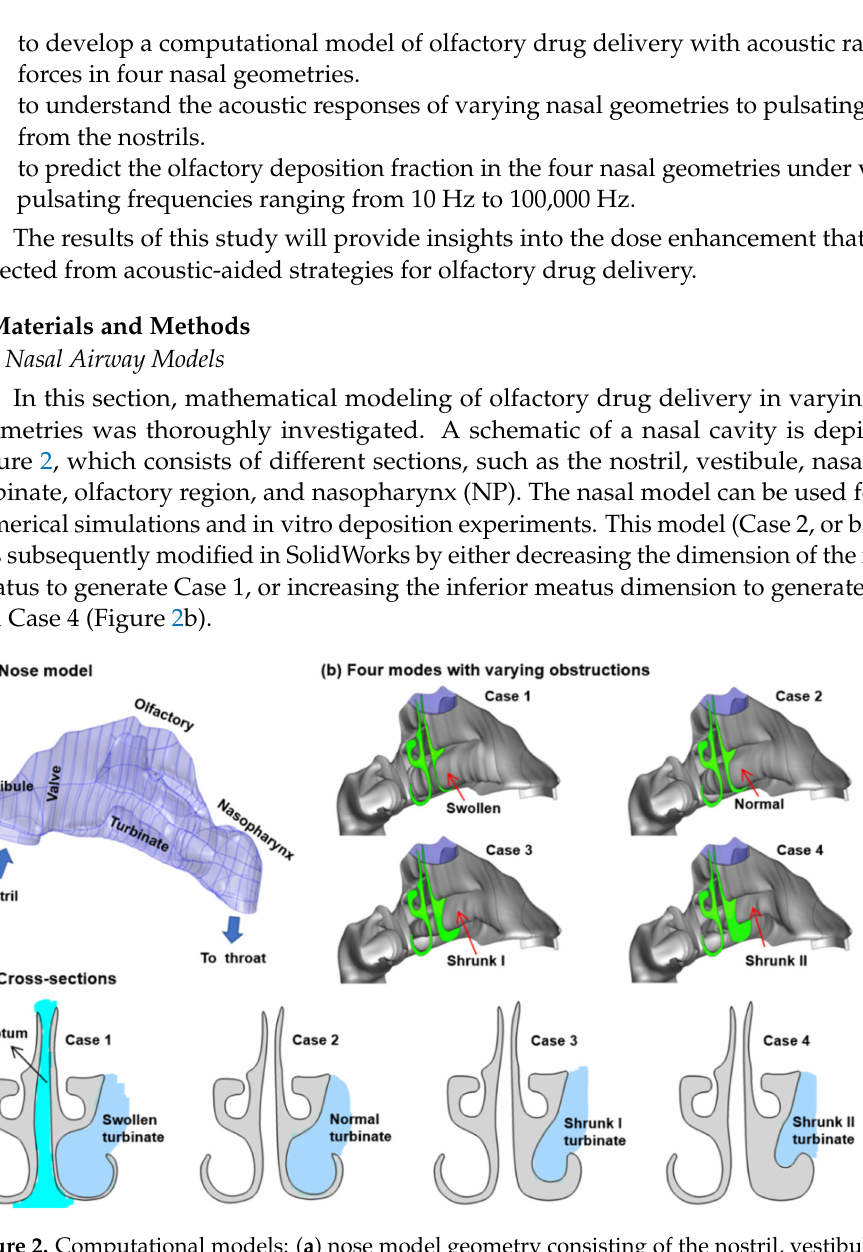
Figure 2. Computational models: ( a ) nose model geometry consisting of the nostril, vestibule, nasal valve, turbinate, nasopharynx, and the olfactory region, ( b ) four models with varying obstructions: Cases 1–4 with a progressively shrunk inferior turbinate, ( c ) cross-sections of Cases